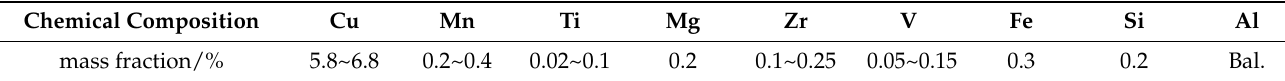
Table 2. Chemical composition of the base